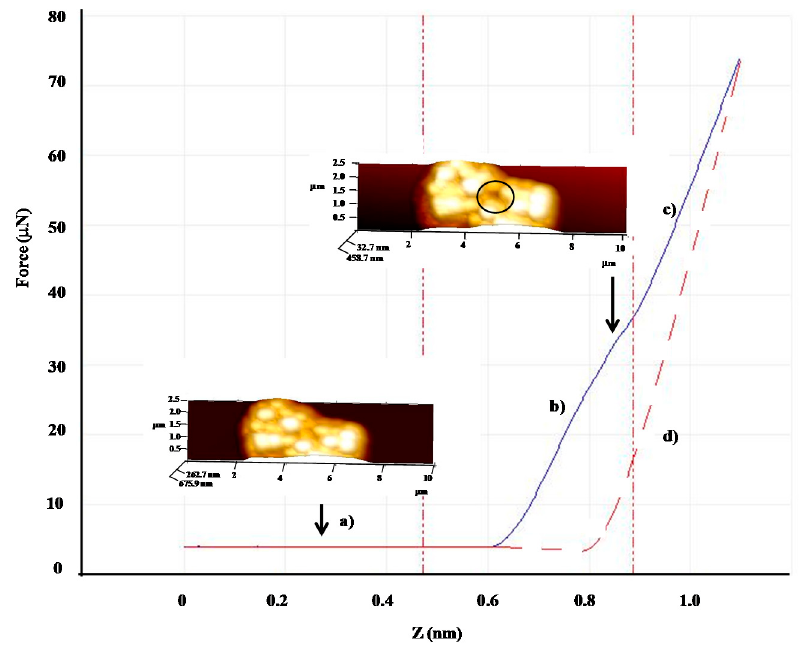
Figure 3. Mechanical testing of the elastic-plastic region by AFM of the MPCM composed by PMMA:tetracosane (1:3) microcapsule at 23 °C: ( a ) image of the sample before applying forces, no contact; ( b ) change in the slope, defined as the maximum force that can be applied to the sample ; ( c ) deformation of the sample; ( d ) retraction of the AFM probe until there is no contact between the tip and the sample.